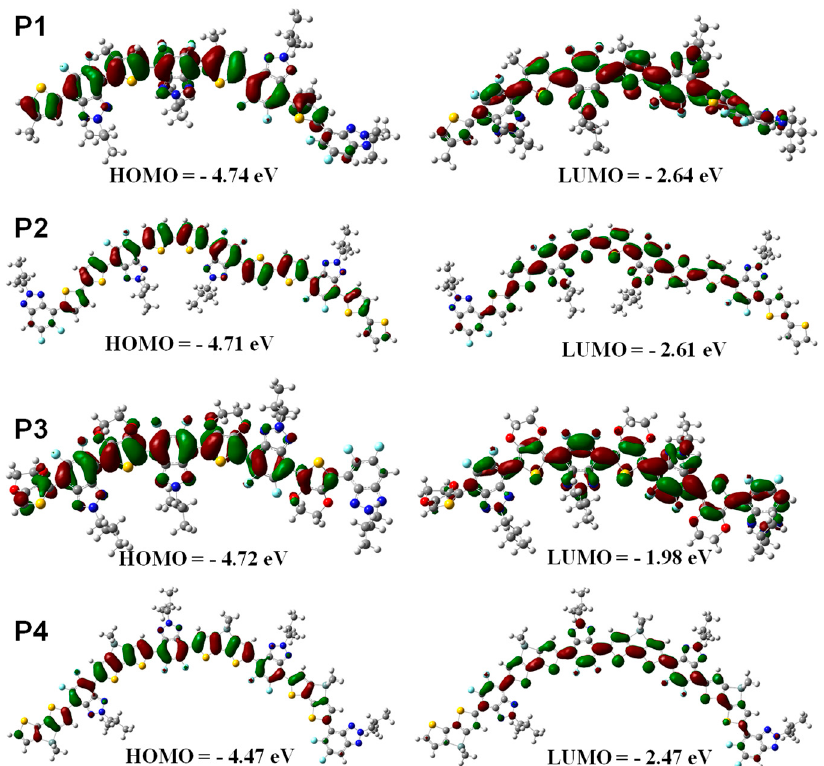
Figure 2. Optimized geometries and molecular orbital surfaces for the HOMO and LUMO values of P1 – P4 obtained using a DFT/B3LYP/6-31G*